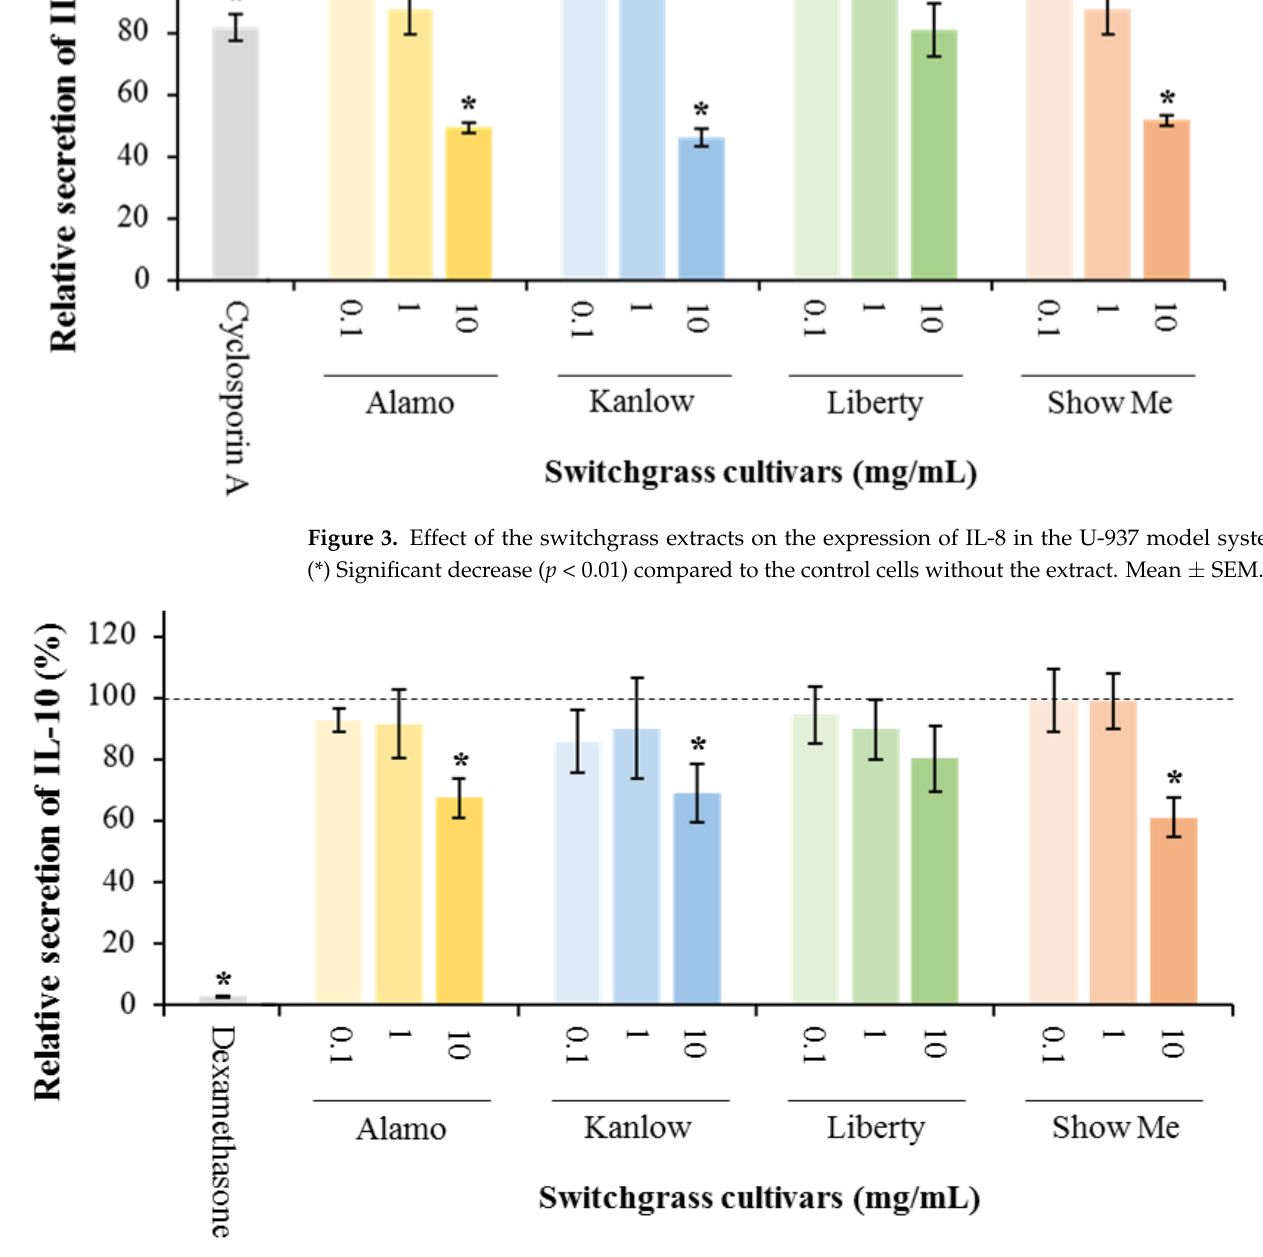
Figure 4. Effect of the switchgrass extracts on the expression of IL-10 by in the U-937 model system. (*) Significant decrease ( p < 0.01) compared to the control cells without the extract. Mean ± SEM.